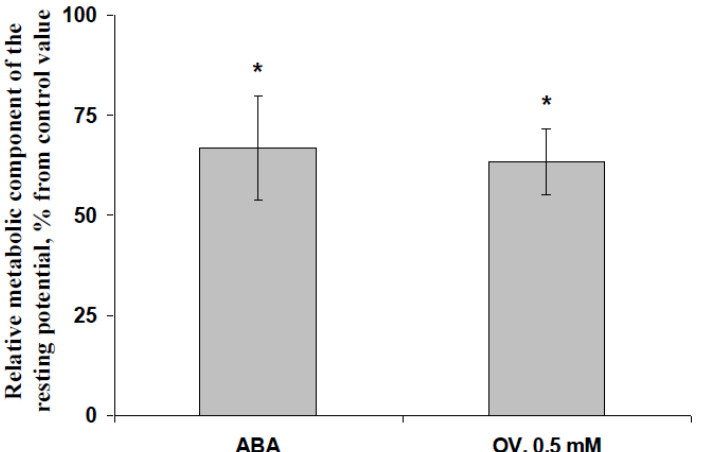
Figure 7. Relative values of the metabolic component of the resting potential in pea seedlings after treatment by ABA and a moderate concentration of sodium orthovanadate (OV) ( n = 5–7). The ABA treatment of seedlings was performed by spraying them with aqueous solutions (10 − 5 M) 1 day before electrical measurements; control plants were treated with equal volumes of water. The preliminary treatment with the moderate OV concentration in the second mature leaf in seedlings was performed by incubation of the leaf (2 h) in a solution of OV (0.5 mM); after that, this leaf was dried by filter paper and was used for the measurement of electrical activity. Similar treatment by water was used in the control. Measurements of the metabolic component of the resting electrical potential across the plasma membrane were performed with the addition of a high concentration of OV (5 mM) during the electrical record; only short-term changes in the membrane potential were analyzed (see Figure S2 for details). The metabolic component was formed by the active transport of H + across the plasma membrane, i.e., it was strongly related to H + -ATP-ase activity in the plasma membrane. Relative values of the metabolic components were calculated as the ratio of experimental values to control ones. *, di ff erence between experiment and control plants is significant ( p < 0.05).